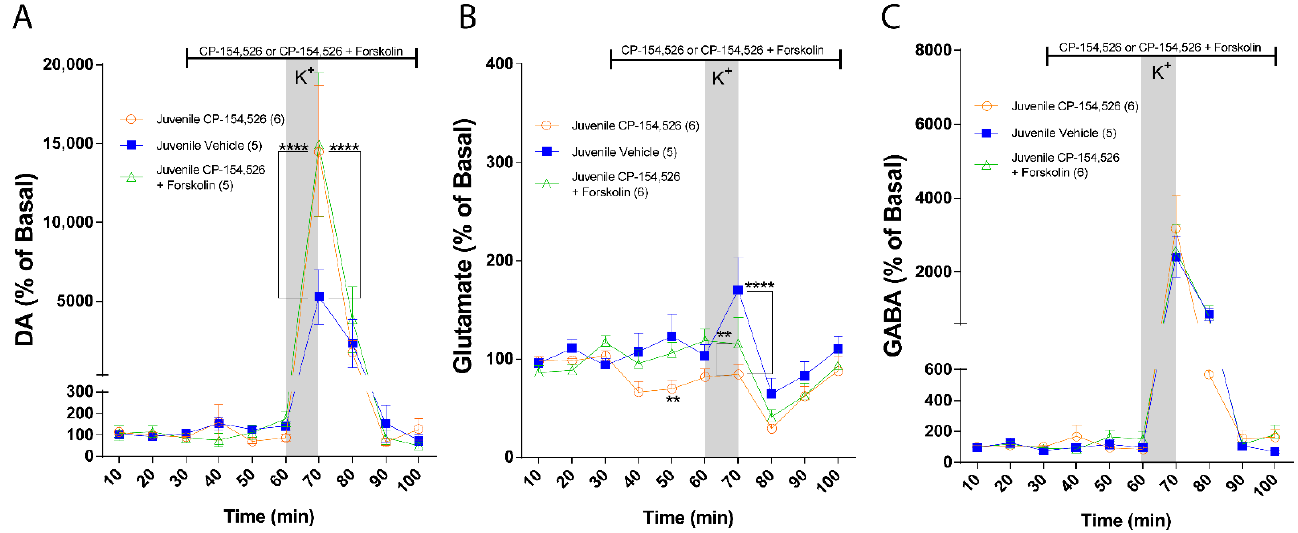
Figure 6. CRF-R1 signaling pathway in NAc of juvenile rats. Measurement of NAc extracellular neurotransmitter levels using in vivo microdialysis, the vertical gray bar indicates the time of local infusion of 70 mM K+-aCSF, and the horizontal black lines indicate the time of intra-NAc in- fusion of the antagonist, vehicle, or co-infusion of antagonist with Forskolin. ( A ) NAc DA levels in the presence of aCSF (blue; n = 5), 10 µM of CP154,526 (orange; n = 6), and 10 µM of CP154,526 + 50 µM of Forskolin (green; n = 5). DA levels were normalized to the average of the first 3 values for each condition and expressed as percentage. Two-way ANOVA revealed no effect of treatment (F